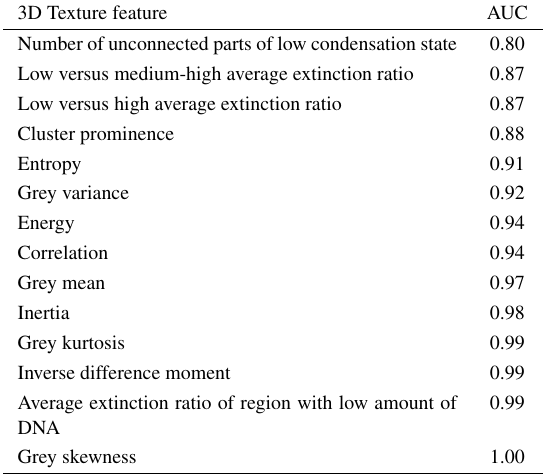
Discriminative power of 3D nuclear texture features for benign and malignant prostate nuclei imaged from a prostatectomy specimen in thick tissue sections by CLSM stained with TO-PRO-3. The texture features having an AUC of 0.80 or greater in ROC analysis are